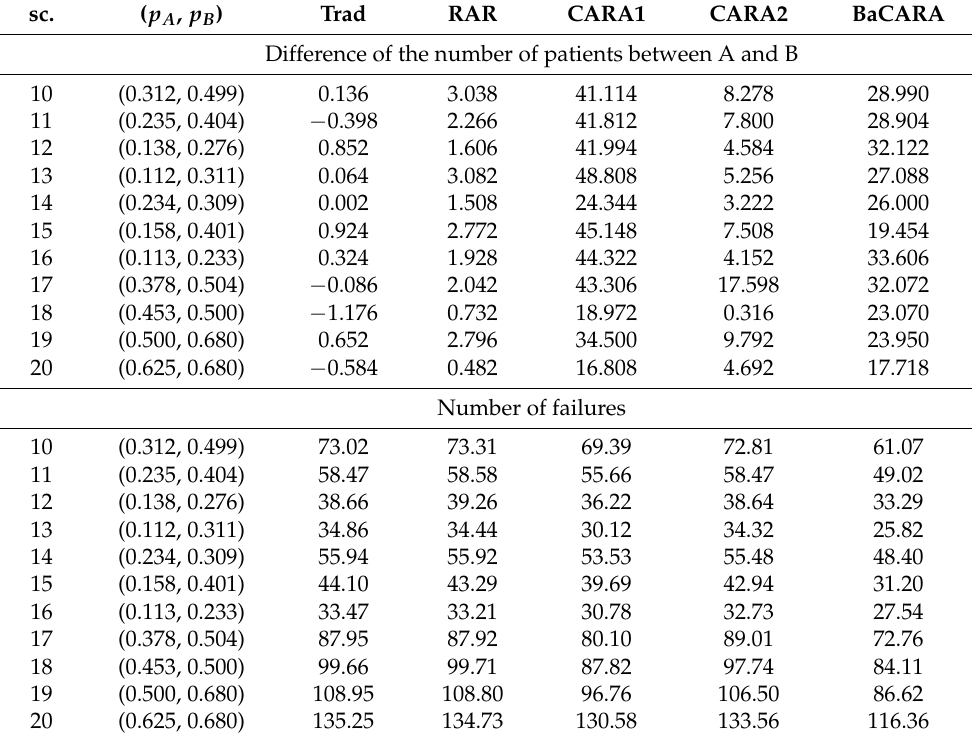
Table 4. Simulation results: other operating characteristics of the designs when x 1 and x 2 are independently generated from a Bernoulli distribution with response probability 0.5. Note that “sc” denotes